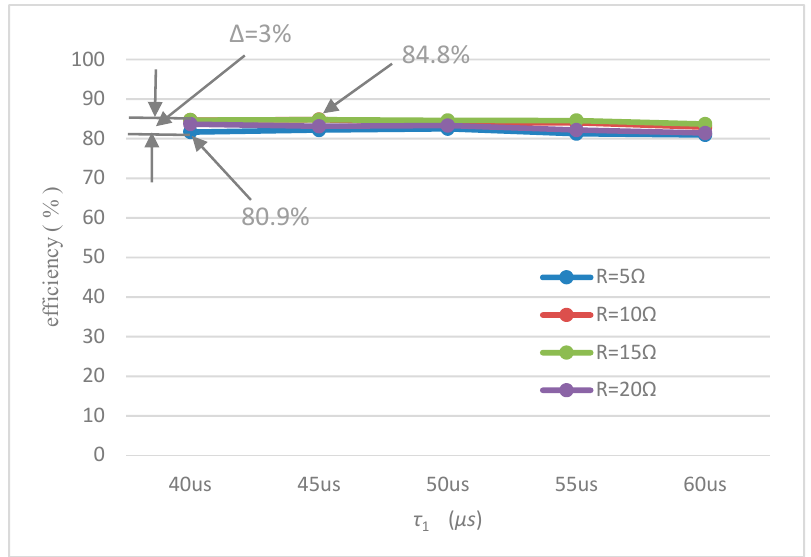
Figure 16. Total efficiency ( U DC -load) versus the energy injection period τ 1 under condition of U DC = Figure 16. Total e ffi ciency ( U DC -load) versus the energy injection period τ 1 under condition of 300 V and k = 0.2. U DC = 300 V and k =